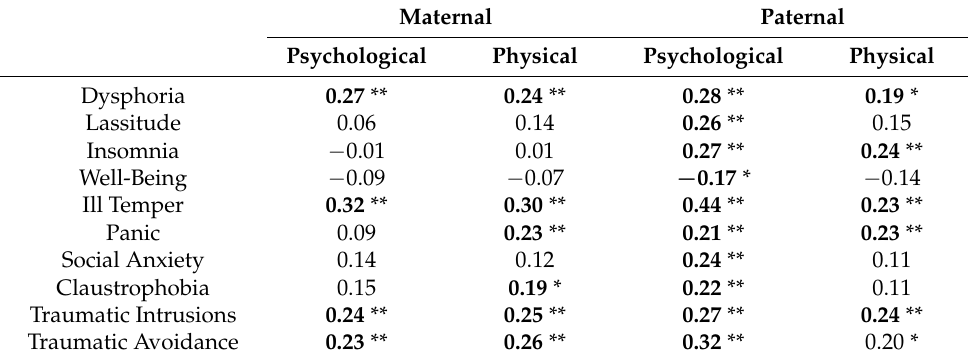
Table 2. Correlations between Aggression in the Couple Relationship and IDAS-II Scales.